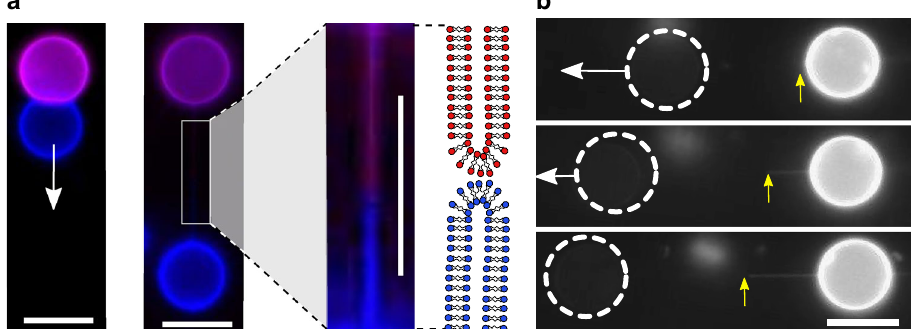
Fig. 5 Linking vesicles over long distances through tethers. a Tethers between two vesicles were formed when one vesicle was pulled relative to another stationary surface-adhered vesicle. White arrow indicates direction of pulling. Labelling each vesicle with a different fl uorophore (Rh-PE = purple; NBD-PE = blue) demonstrates the existence of two sub-tethers, one from each vesicle, which met at the middle and anchored on a sub-micron adhesion patch. b The precise location of the anchor point (yellow arrow) could be varied by extending the tether by pulling the vesicle. Dotted white circles represent location of a non- fl uorescence vesicle. Scale bar = 10 µ m for all